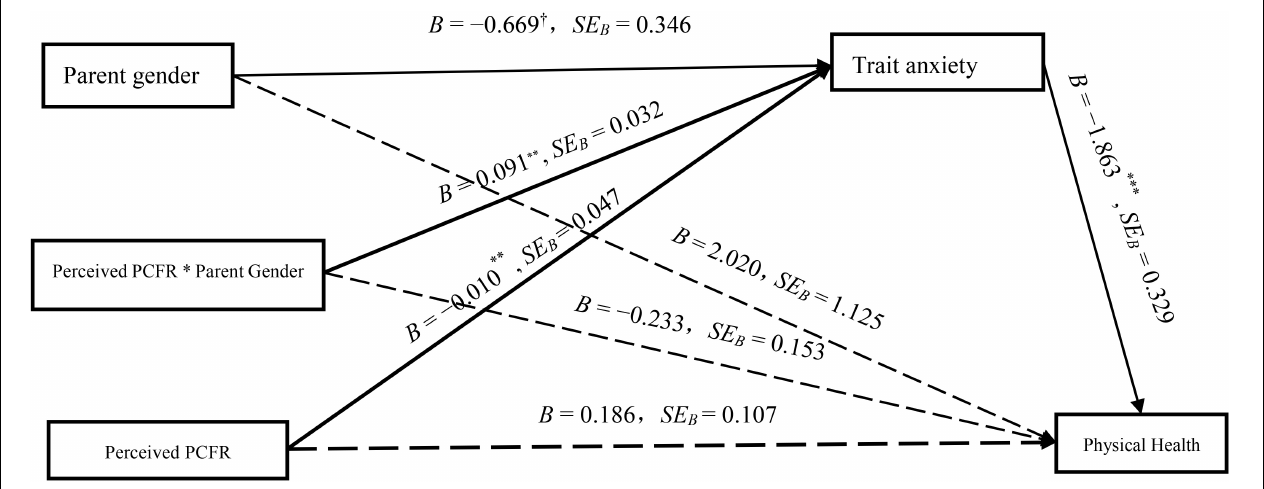
FIGURE 3 | The moderating effect of parent gender and mediating effect of trait anxiety on the relationship between perceived PCFR and parental physical